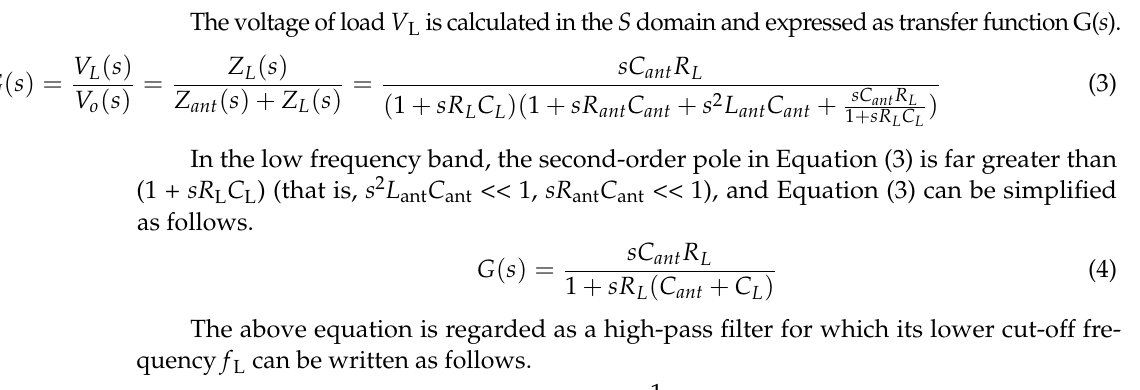
Figure 5. Equivalent circuit of the sensor.